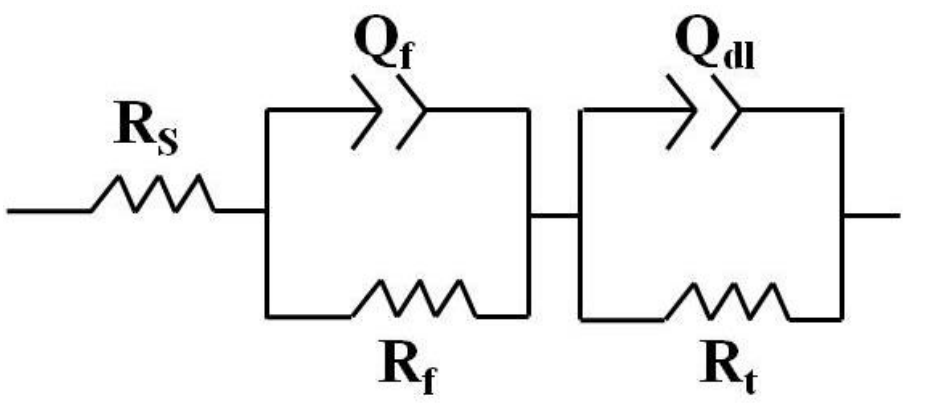
Figure 5. ( a ) Bode plots and ( b ) Nyquist plots of the different annealed conditions in Hank’s solu- tion.